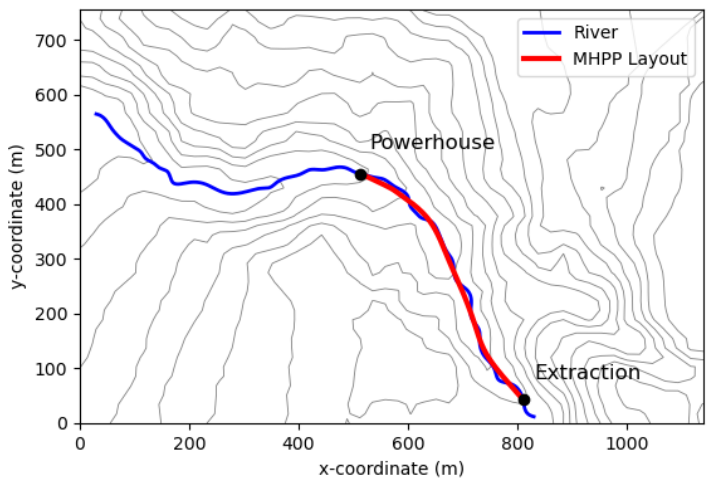
Figure 13. Layout of the optimal solution obtained for the reference problem.